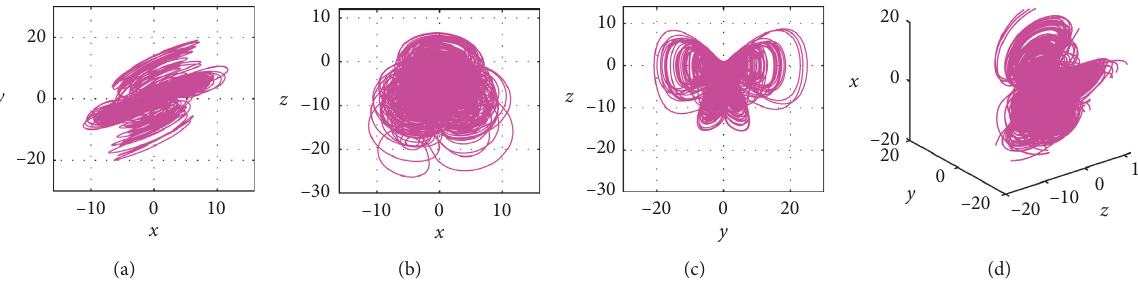
Figure 1: The four-wing hyperchaotic attractor of system (2): (a) in the x − y plane, (b) in the x − z plane, (c) in the y − z plane, and (d) in the x − y − z space.